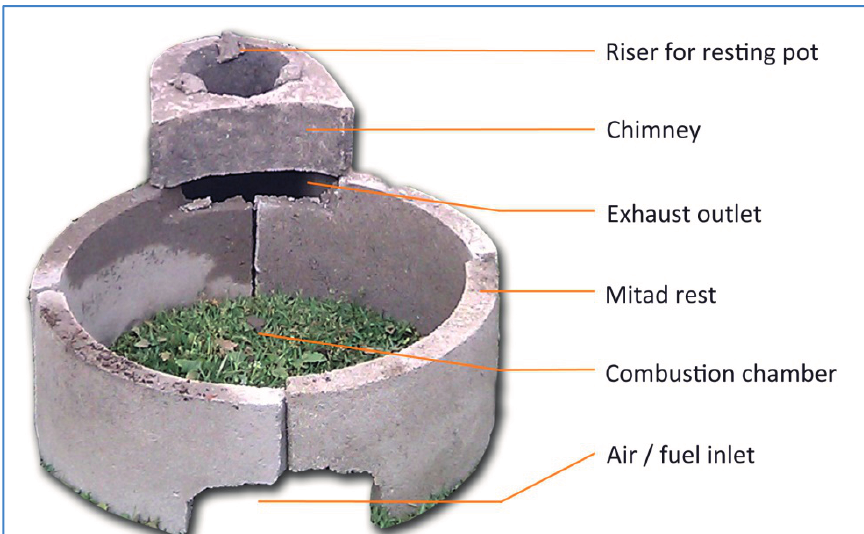
Figure 2. “ Mirt ” stove, slim